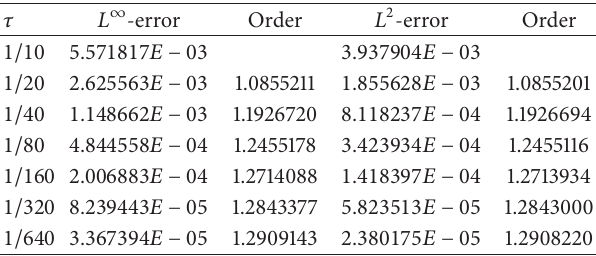
Table 2: Temporal errors and convergence orders with 𝛼 = 1.7